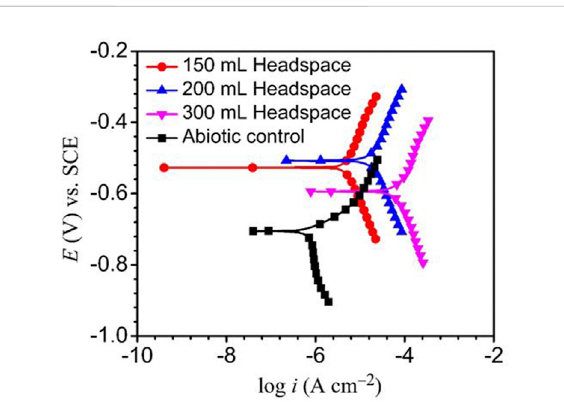
FIGURE 7 Potentiodynamic polarization curves at end of 14-day incubation with SRB, and without SRB (abiotic